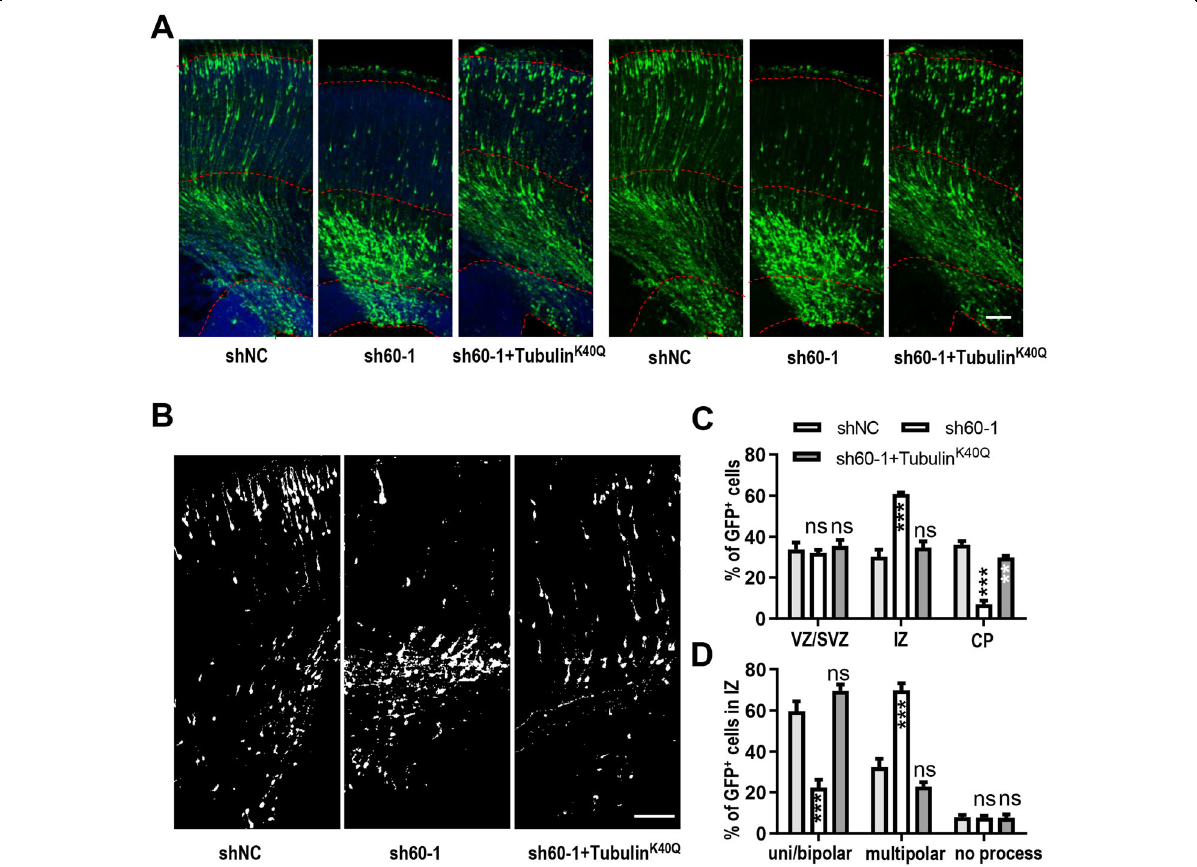
Fig. 4 Mimicked Acetylated- α -Tubulin can rescue the migration defects caused by WDR60 de fi ciency. a , b Images of rat cortical sections electroporated in utero with the indicated constructs at E16.5 and examined at E20.5. b Images of transfected cells. Scale bars, 100 μ m. c Quanti fi cation of the distribution of EGFP + cells. n : 6 slices from 3 mice. d Quanti fi cation of EGFP + cells exhibiting different morphology in the IZ. n : 6 slices from 3 mice. All data are means ± SEM, t -test. ** p <0.01, *** p